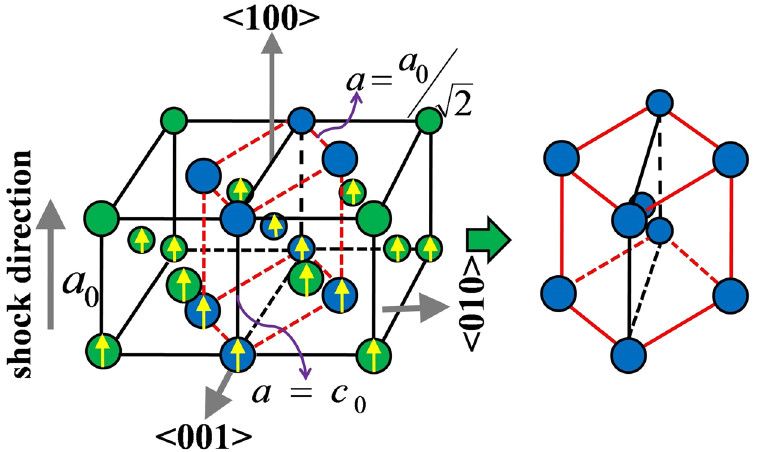
Figure 6. Schematic of atomistic mechanism of structural phase transition in Cu(100) direction. BCT unit cell in between two FCC lattice has been shown by blue colored balls connected by red dashed lines. Yellow colored arrow signifies uniaxial atomic displacement under shock